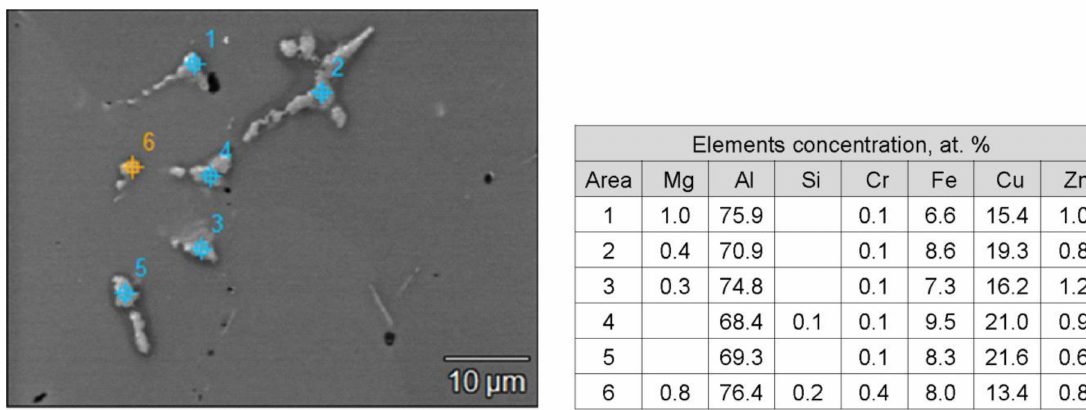
Figure 8. Examples of particles containing Al, Cu, and Fe as well as Mg 2 Si in observed in the microstructure of 7075 alloy 2 after soaking at 475 ◦ C for 8